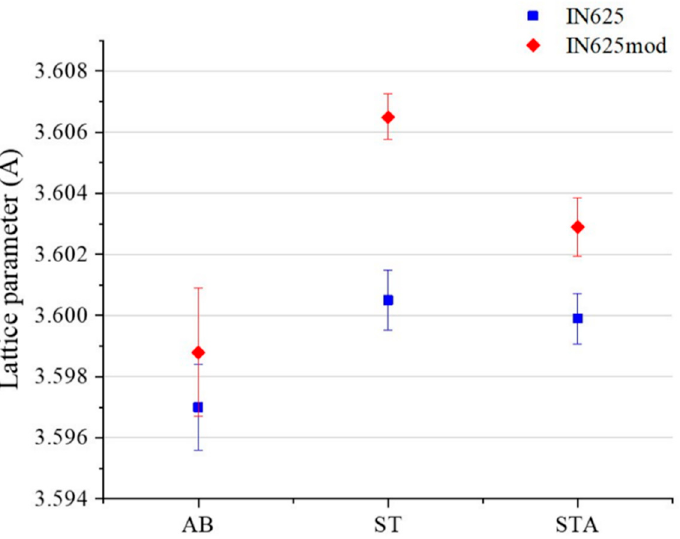
Figure 7. Figure 7. Lattice parameter of the austenitic matrix of the AB and heat-treated IN625 and IN625mod versions.